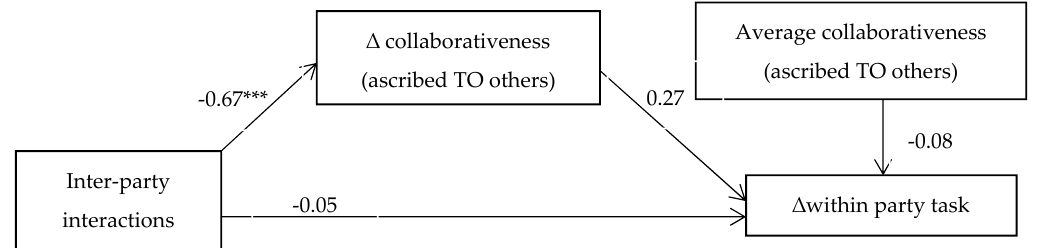
Figure 5. The overall mediation model for change in tach conflict and collaborativeness (top down influence). Notes: *** p < 0.001, Δ task conflict = task conflict at time 2 minus task conflict at time 1, Δ collaborativeness = collaborativeness as perceived by each party for the system as a whole at time 2 minus collaborativeness as for the system as a whole at time 1.